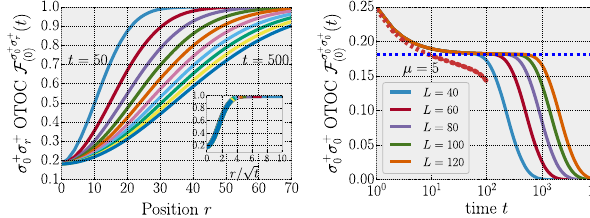
FIG. 12. The OTOC F between ˆ σ þ 0 and ˆ σ þ r at infinite chemical potential. Left: The OTOC as a function of initial distance r for times t ¼ 50 ; 100 ; … ; 500 in an infinite system. The OTOC spreads diffusively and saturates to a “ prethermal ” plateau behind the front. The inset shows the data collapse when the position is ffiffi p t rescaled as r → r= . Right: The OTOC first saturates to the ffiffi p − ð 1 = π Þ (dashed horizontal line) as 1 = t value 1 . Then at a later 2 timescale t ∼ L 2 it decays to zero. At late times its value decreases as exp ð − π 2 t=L 2 Þ . The red dashed line shows the next-order prediction at μ ¼ 5 , which indicates that the plateau survives up to a timescale that diverges with μ